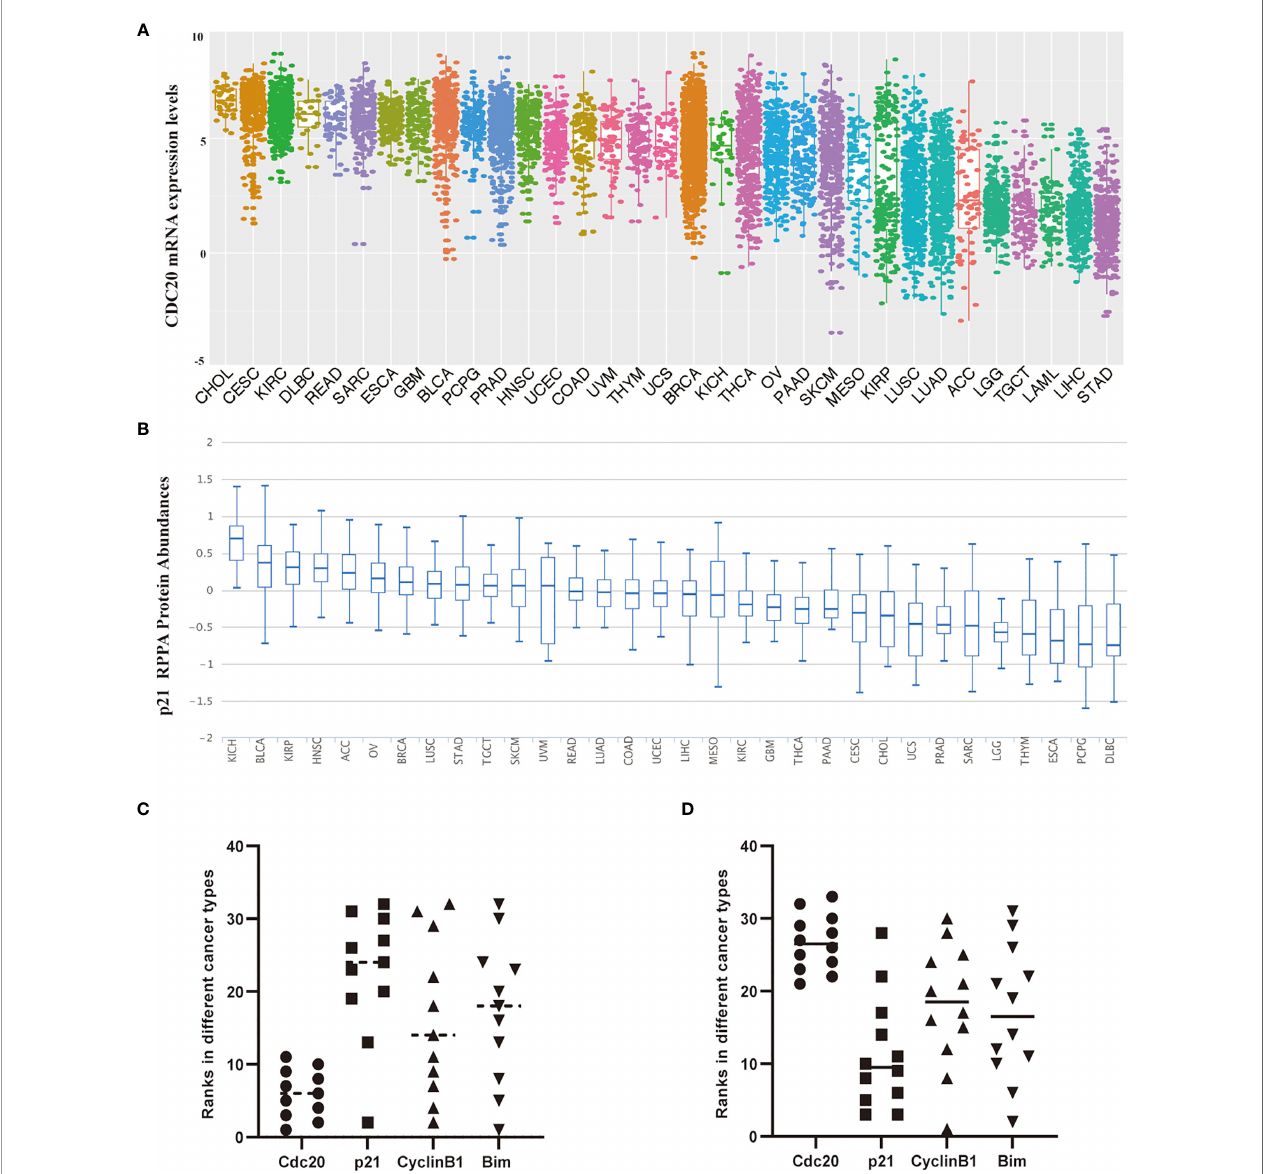
FIGURE 5 | The correlation of protein abundance between Cdc20 total protein and its ubiquitination substrates in different cancer types. (A) The mRNA expression levels of the CDC20 gene in speci fi c cancers or cancer subtypes from the TCGA database. The names of cancer types or subtypes are arranged in descending order of CDC20 express levels. (B) The p21 protein levels in different types of cancers by RPPA using the samples from TCGA. The names of cancer types or subtypes are arranged in descending order of p21 protein abundance. (C) Scatter plots visualize the ranks of Cdc20 and its substrates(p21, CyclinB1, and Bim) in speci fi c cancer types. The cancer types in the top 11 ranks with Cdc20 high expression are selected. (D) Scatter plots visualize the ranks of Cdc20 and its substrates(p21, CyclinB1, and Bim) in speci fi c cancer types. The cancer types in the last 12 ranks with the Cdc20 expression list are